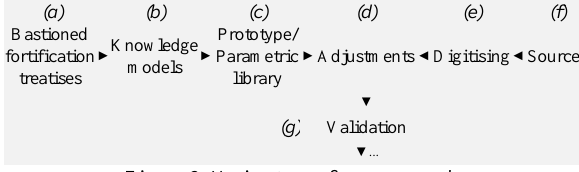
Figure 2. Main steps of our